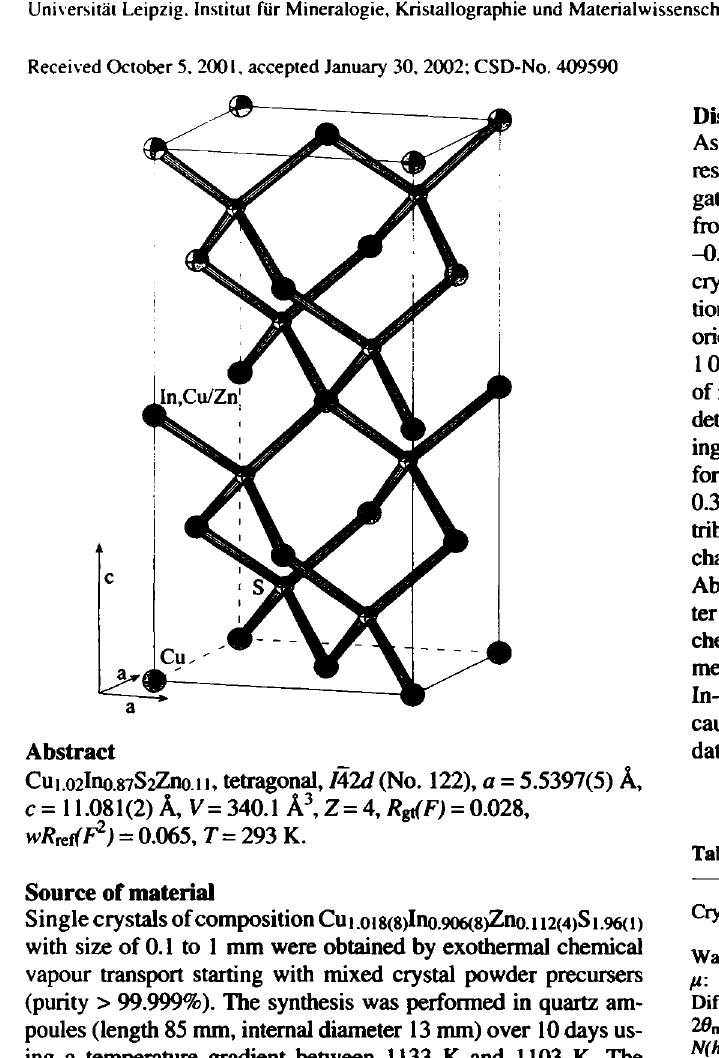
Table 2. Atomic coordinates and displacement parameters (in Â 2